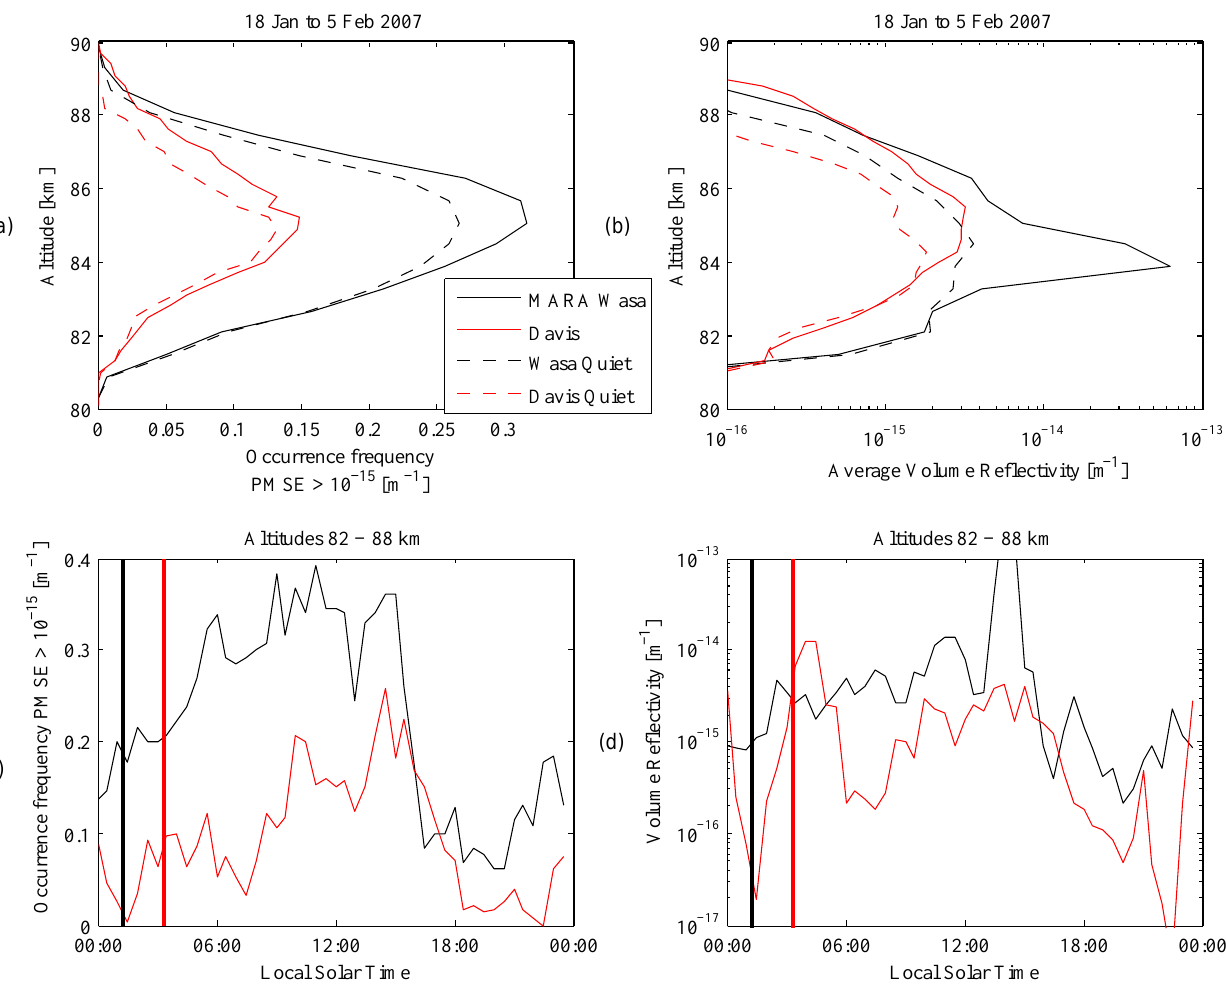
Fig. 4. The two upper panels show average altitude profiles of PMSE occurrence frequency (left) and PMSE volume reflectivity (right). The solid lines show the average for all days. Dashed lines show the average when days with unusually strong PMSE have been removed (see text for details). The two lower panels shows the average occurrence frequency (left) and the average volume reflectivity (right) in the altitude interval 82–88km as a function of local solar time. Data from MARA Wasa are shown with a black line, data from Davis with a red line. Thick vertical bars indicate magnetic midnight at Wasa (black) and at Davis (red).